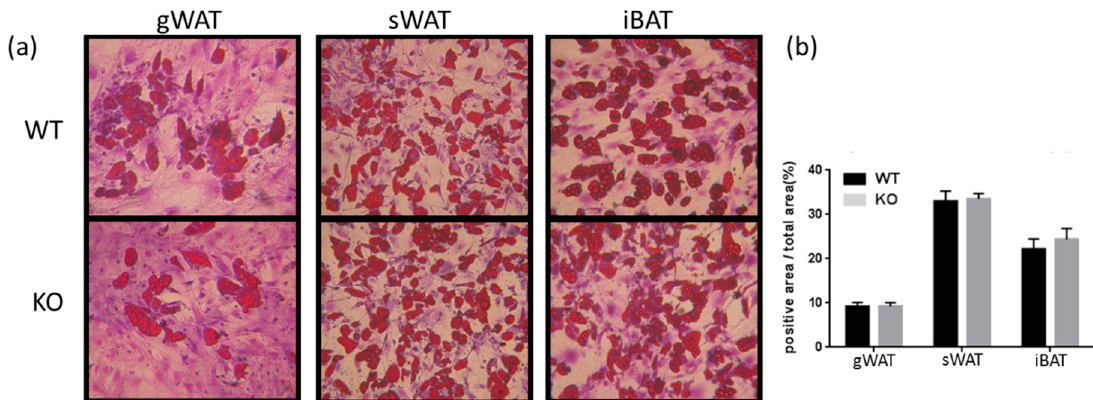
Figure 2. The adipogenic differentiation capacity of stromal vascular fraction (SVF) cells . ( a ) SVF cells isolated from gWAT, sWAT, and iBAT from WT and Tks4-KO mice were treated with adipogenic medium for 7 days and then stained with Oil Red O to visualize the lipid droplets and dimethyl methylene blue to stain the cytoplasm. Representative images (original magnification: 10×) and ( b ) quantification of the Oil Red O staining.